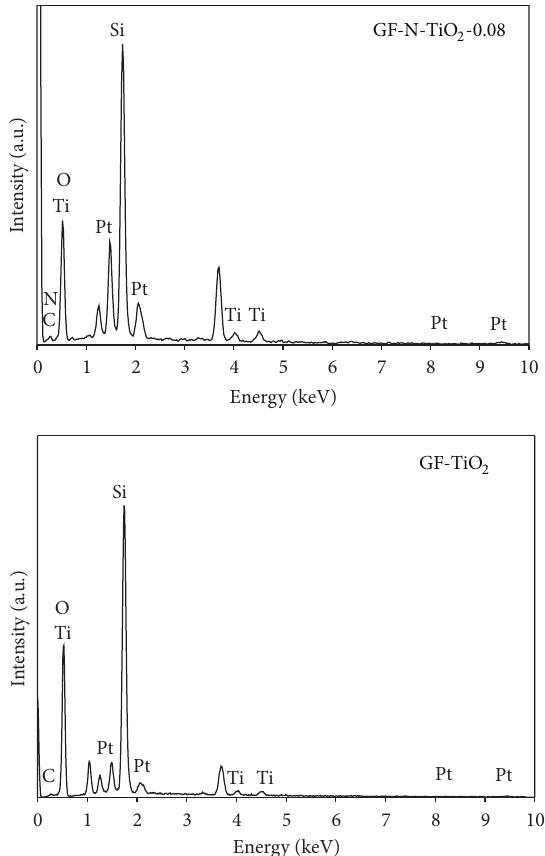
Figure 3: Energy-dispersive X-ray images of GF-N-TiO 2 with a N- to-Ti ratio of 0.08 (GF-N-TiO 2 -0.08) and GF-TiO 2 .